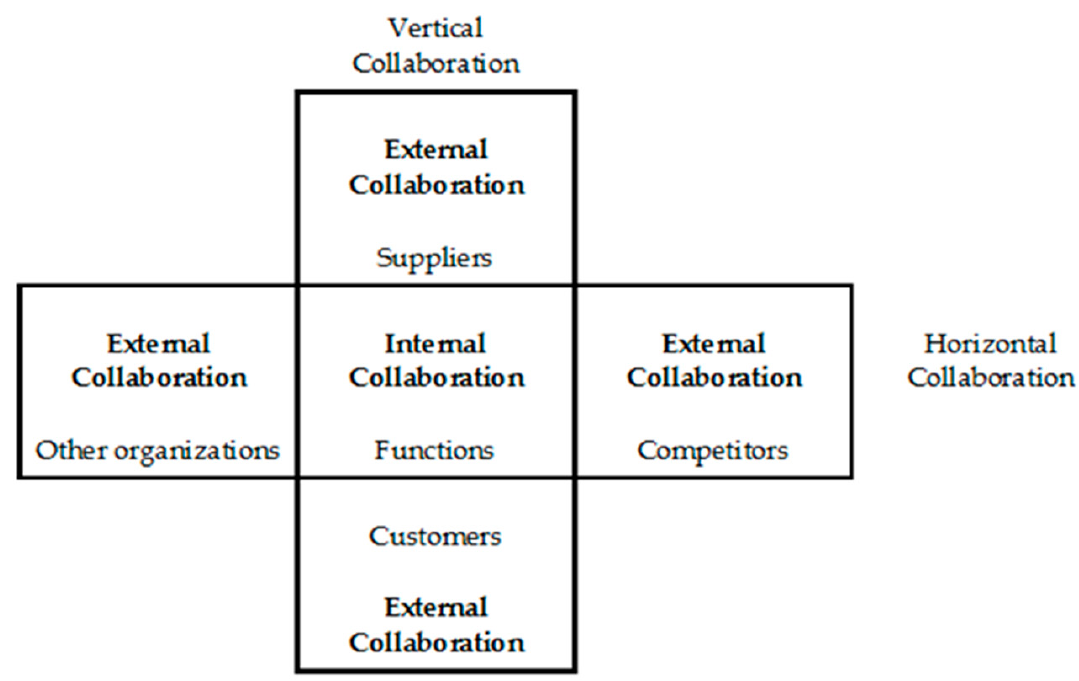
Figure 2. The scope of collaboration.